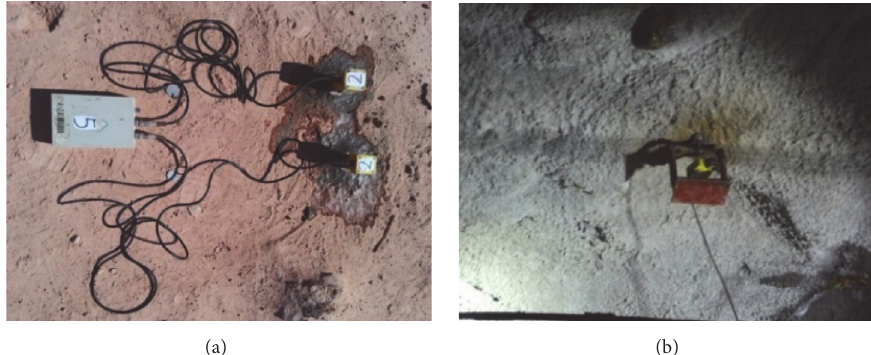
Figure 3: Installation patterns on the bench and in the tunnel. (a) Surface. (b) Underground.